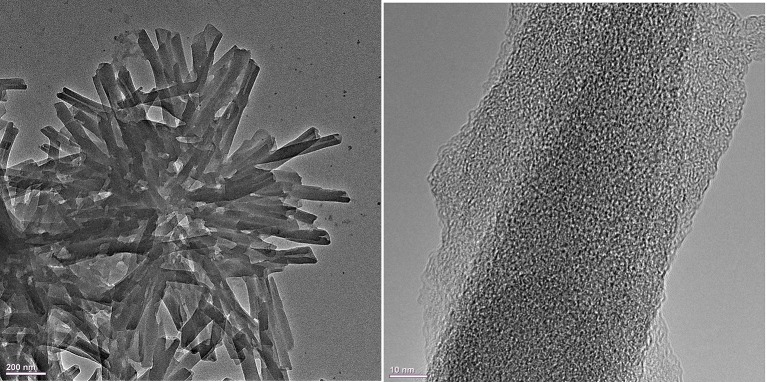
TEM images of the H4TPPS42- –Sn(IV)TPyP4+ porphyrin nanostructures formed in equimolar porphyrin solutions at pH = 2.0 by the self-assembly reaction.